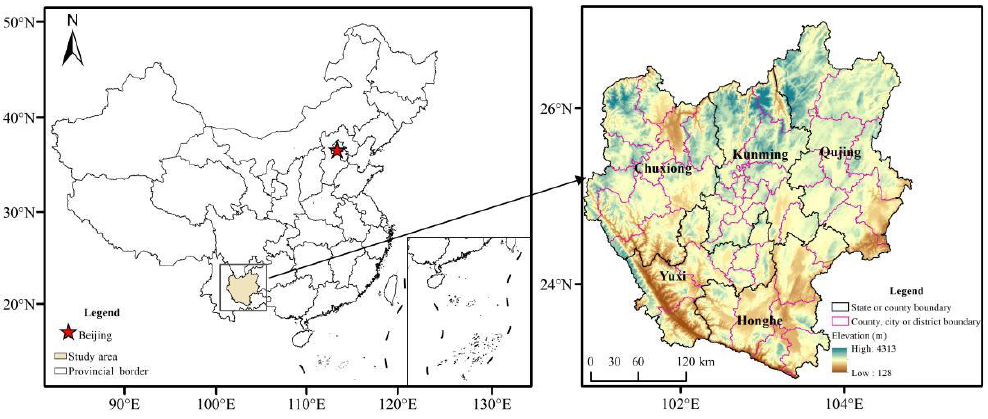
Figure 1. Location of central Yunnan urban agglomeration in China.